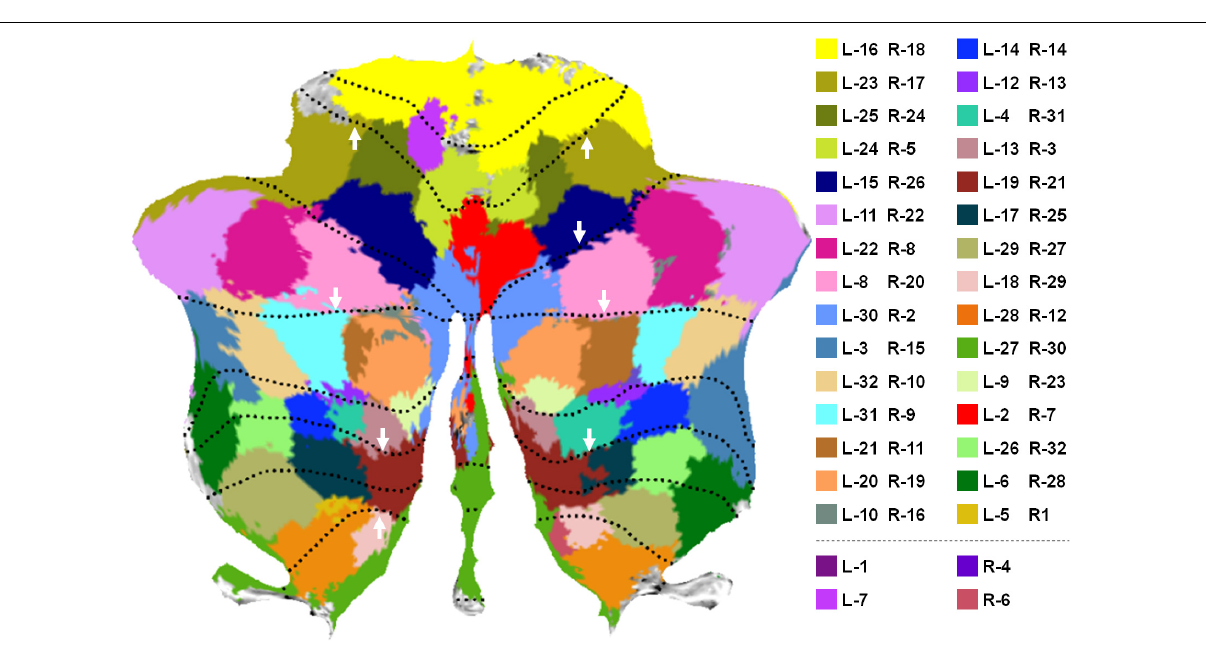
FIGURE 2 | Parcellations were visualized on a flattened cerebellum map. Parcellation boundaries that well matched the lobular boundaries were highlighted by white